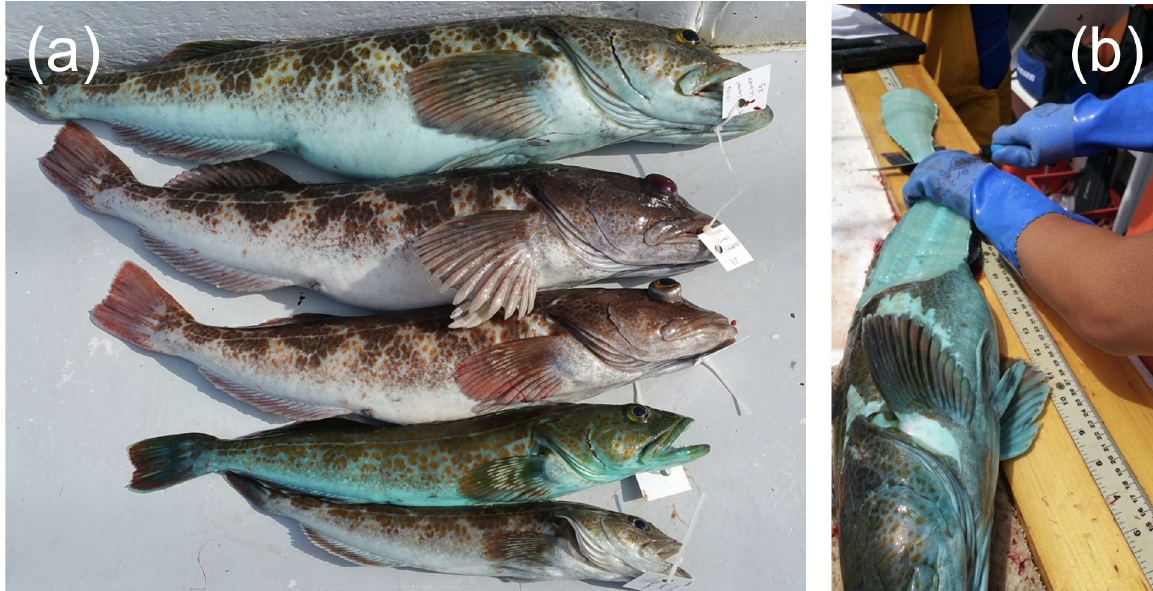
Fig 1. (a) Lingcod ( Ophiodon elongatus ) of two color morphs: blue (topmost and fourth-from-top) and brown (second-from-top, third-from- top, and bottommost). (b) Blue coloration affects both external and internal tissues. Courtesy of Laurel Lam /